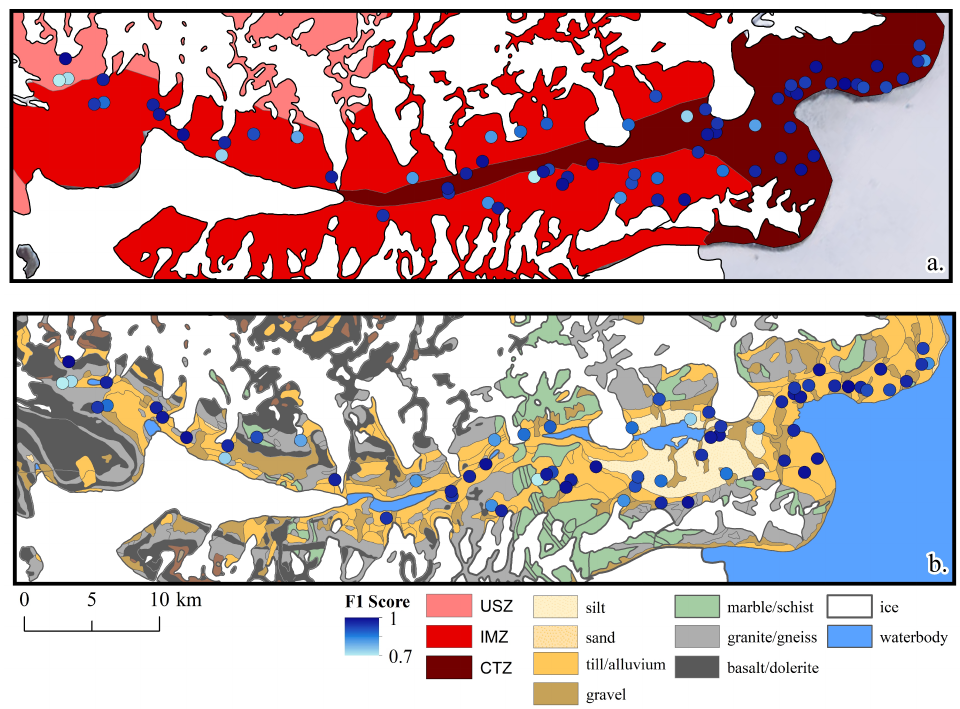
Figure 7. Spatial performance of stream boundary prediction in comparison to ( a ) microclimate zones with the Coastal Thaw Zone (CTZ) in dark red, the Inland Mixing Zone (IMZ) in red and the Upper Stable Zone (USZ) in light pink ( b ) geology. The points represent the F1 score from low (white) to high (blue). The colors from tan to yellow represent sediment grain size types while the green, grey and black color represent bedrock types.